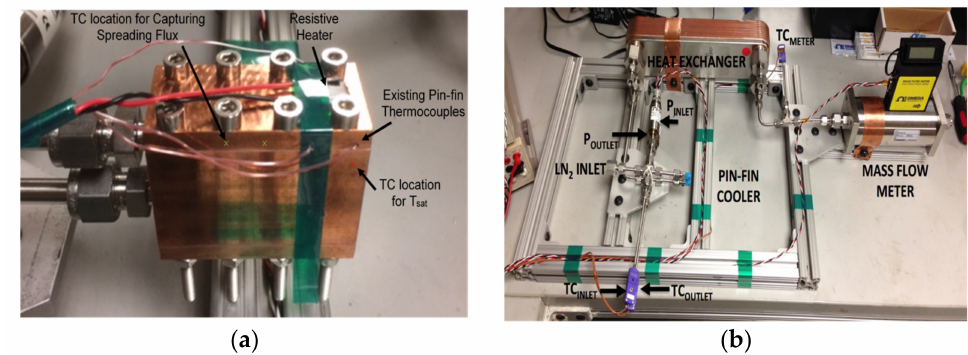
Figure 4. ( a ) Micro-pin fin cooler manifold; ( b ) Assembled LN 2 flow loop apparatus.